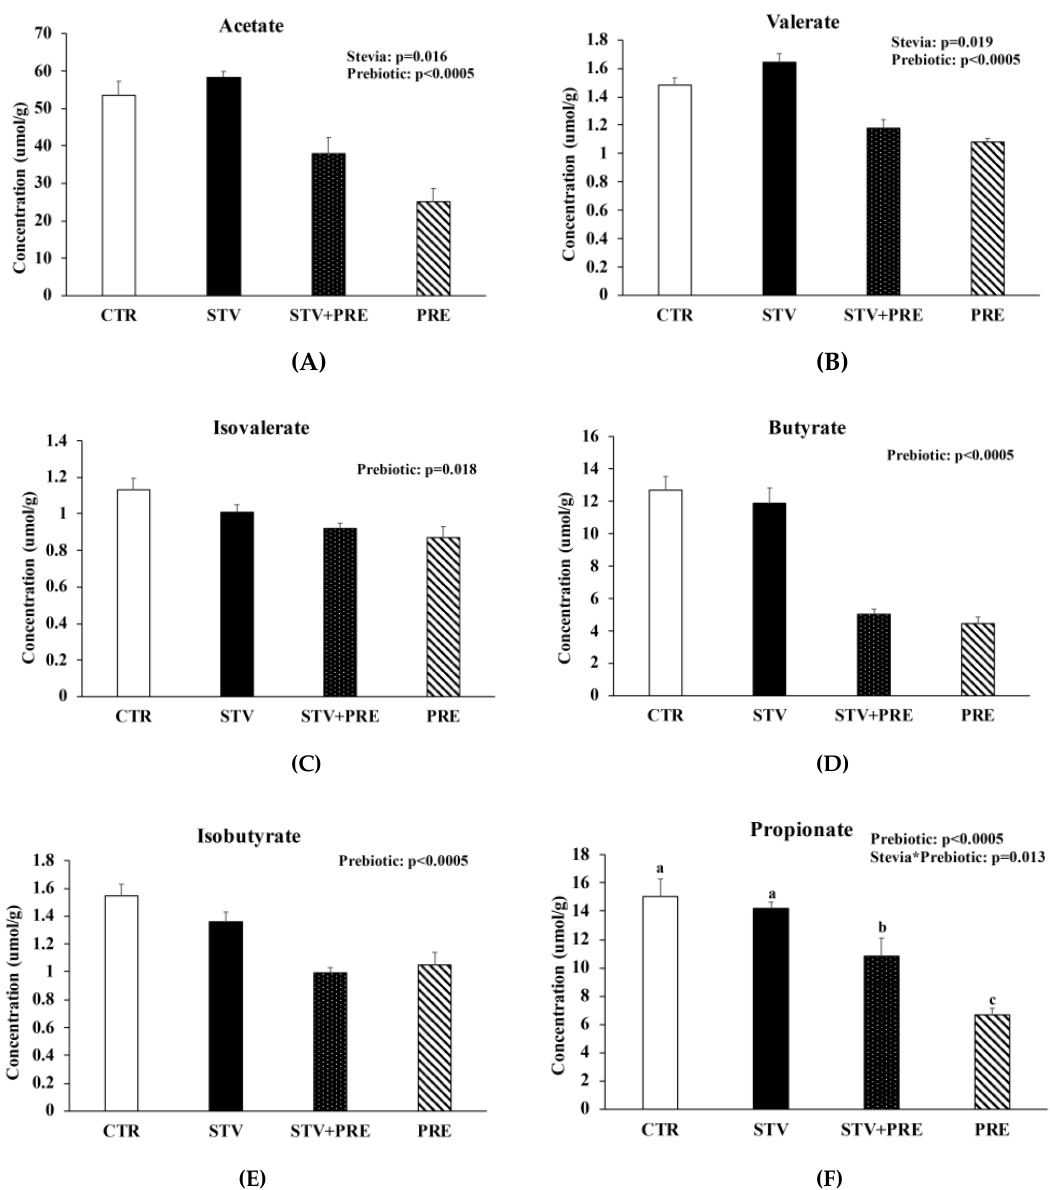
Figure 5. Prebiotics reduced cecal short chain fatty acid concentration and RebA consumption increased acetate and propionate cecal short chain fatty acid concentration. (a) Acetate; (b) valerate; (c) isovalerate; (d) butyrate; (e) isobutyrate; (f) propionate. Values are mean ± SEM, n = 8/group. Labelled means without a common superscript letter (a, b, c) differ, p < 0.05. CTR, control; STV, RebA; STV+PRE, RebA and prebiotic; PRE, prebiotic.